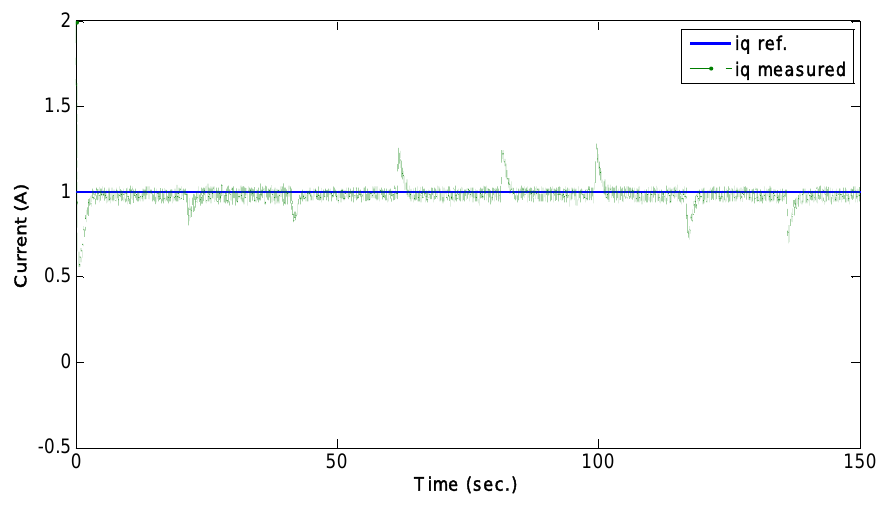
Figure 18. Response of the controlled rotor q